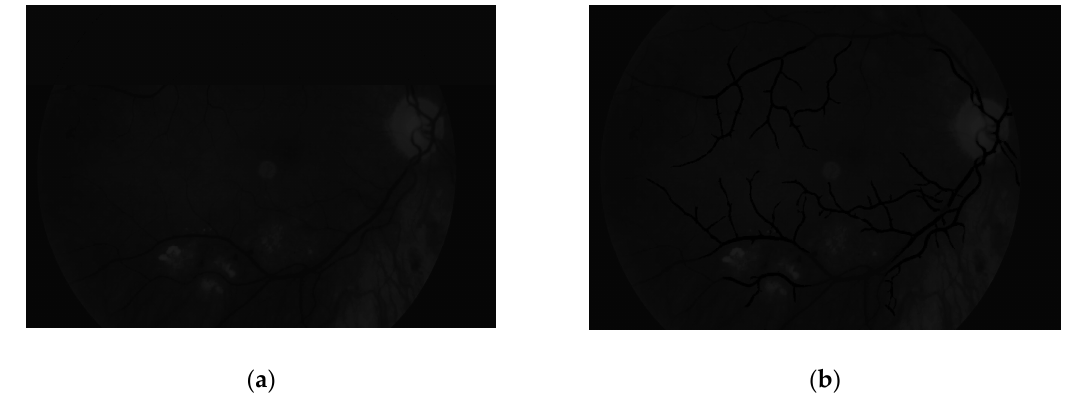
Figure 14. Image ( a ) after the first step and ( b ) after vascular pattern removal.